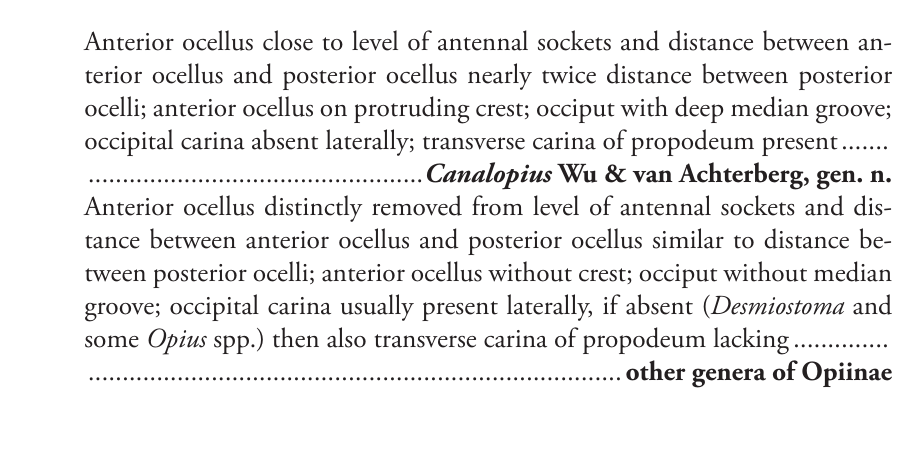
Type material. Holotype, ♀ (RMNH), “N. Vietnam : Hoa Binh, Pa Co Hang